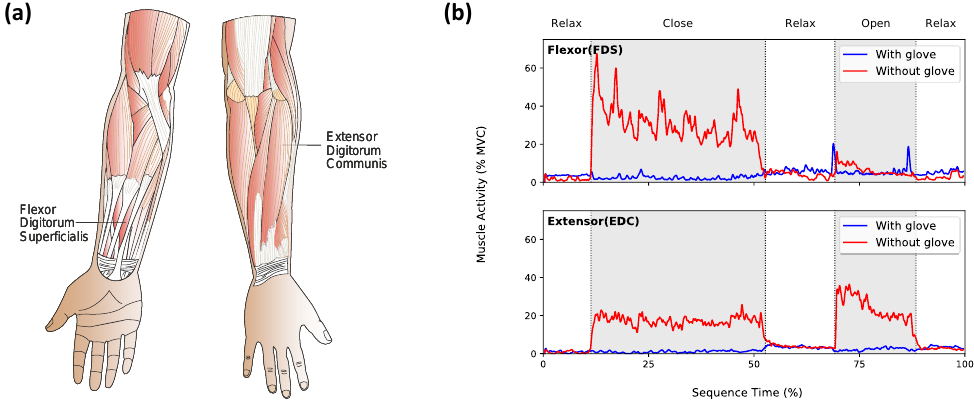
Figure 5. ( a ) EMG sensors’ placement on arm muscles. ( b ) Muscle activity comparison with and without the powered